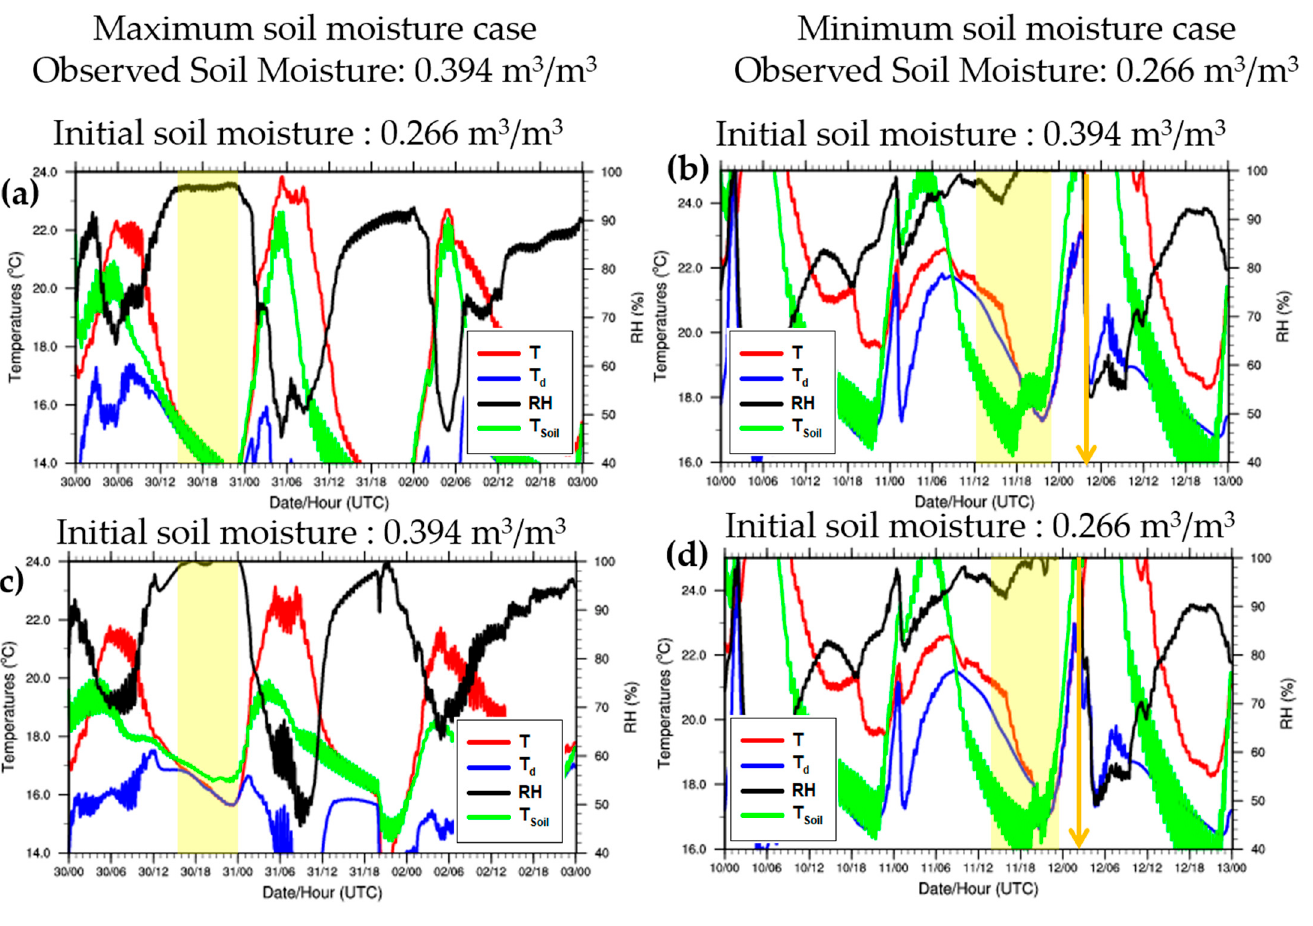
Figure 5. Time variations of T, T d , RH and T s from the simulations for the maximum and minimum soil moisture cases ( a ), ( b ) when the opposite soil moisture content values were applied and ( c ), ( d ) when the actual soil moisture content values were applied. The observed time of fog is shaded yellow. The orange arrow in ( b ) and ( d ) indicates fog dissipation time in each simulation.